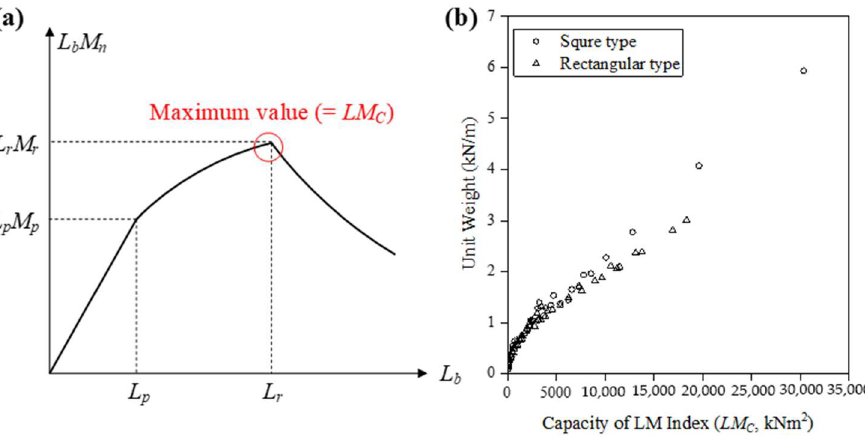
Figure 2. Description of the LM index in hot-rolled H-beam. ( a ) Relationship with the unbraced length. ( b ) Unit weight according to the capacity of the LM index.